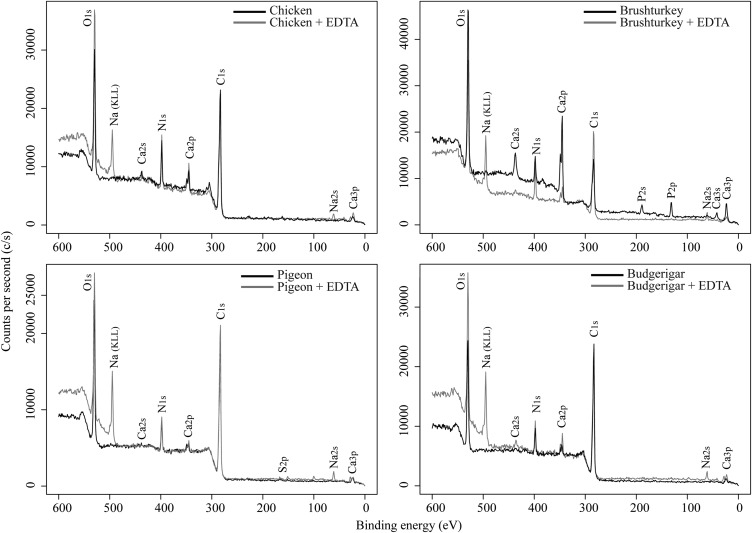
XPS survey spectra showing the chemical composition of eggshells before and after EDTA treatment. The EDTA treatment duration are 90 min for chicken, brushturkey, pigeon, and 30 min for budgerigar. The sodium peak results from the residual presence of EDTA, and was not taken into account to calculate the atomic percentages.